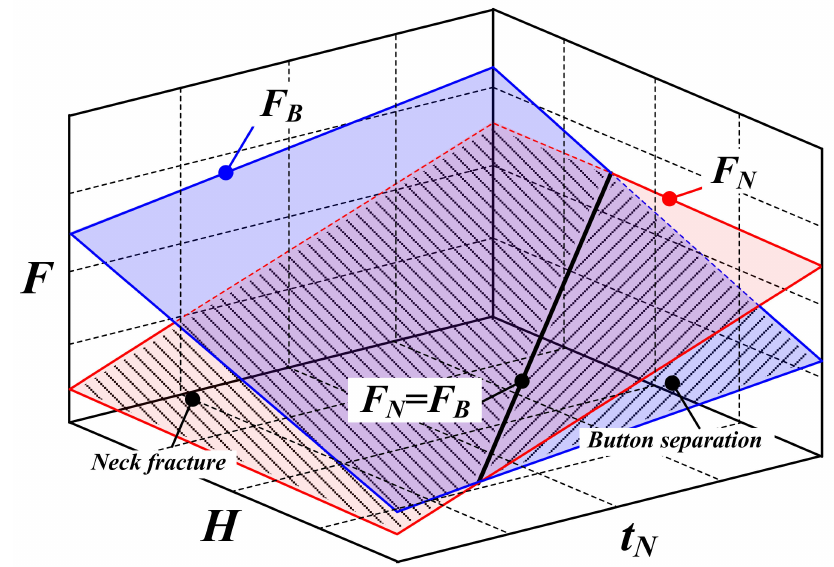
Figure 8. Relationship between the geometrical interlocking parameters and joint